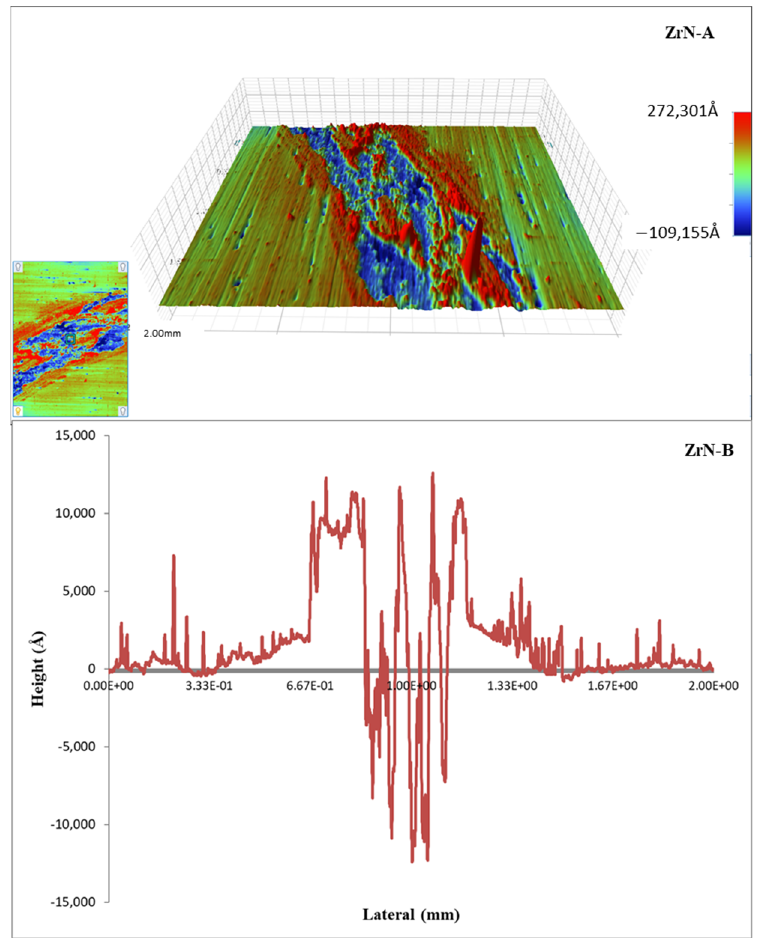
Figure 4. Surface morphology of scratch track of sample ZrN-A and wear profile of sample ZrN-B at normal load of 10 N.